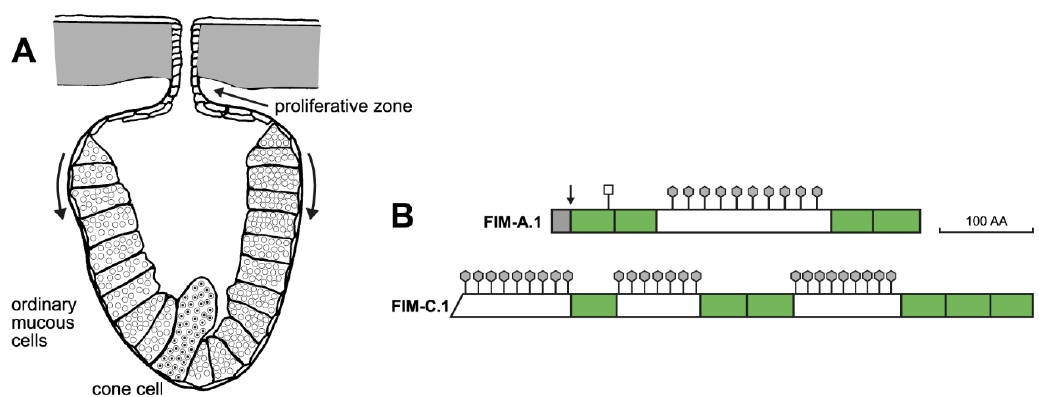
Figure 1. Schematic structure of a mucous gland from X. laevis skin ( A ) as well as the integumentary mucins FIM-A.1 and FIM-C.1 ( B ). ( A ) The postulated migration of ordinary mucous cells towards the base of the gland during self-renewal is indicated by arrows. Also shown are the different types of secretory granules in ordinary mucous and cone cells, respectively. ( B ) The TFF domains in FIMs are shown in green, highly O-glycosylated regions typical of mucins are indicated by hexagons, and a potential N-glycosylation site is indicated with a square. The arrow in FIM-A.1 represents the cleavage site in the precursor by signal peptidase.